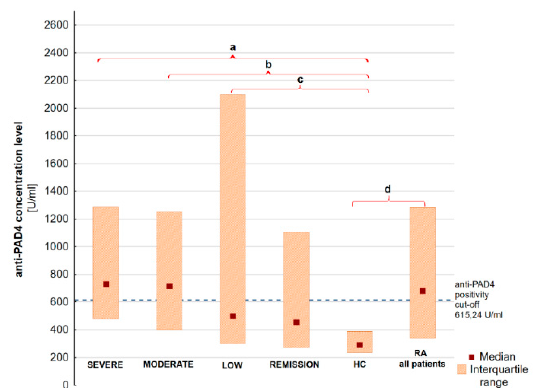
Figure 1. PADI4 promoter gene methylation level in RA groups according to DAS28 activity, HC and all RA patients. Results presented as median and interquartile range. (a) p = 0.00002; (b) p = 0.00004; (c) p = 0.023; (d) p = 0.00001, Remission vs. HC p = 0.07.